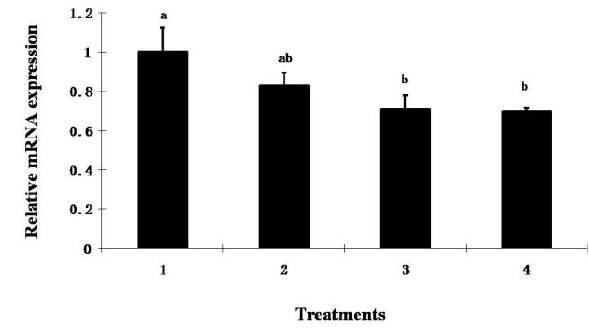
Figure 1. The effect of dietary ALA on Col3A1 mRNA expression in broiler chickens. Diets contained 0 ppm (control), 400 ppm (T1), 800 ppm (T2) and 1,200 ppm (T3) of ALA in diet. a–b Bars with different superscripts are significantly different (p<0.05). Error bars show Table 6. The forward and reverse primers for Col3A1 gene and